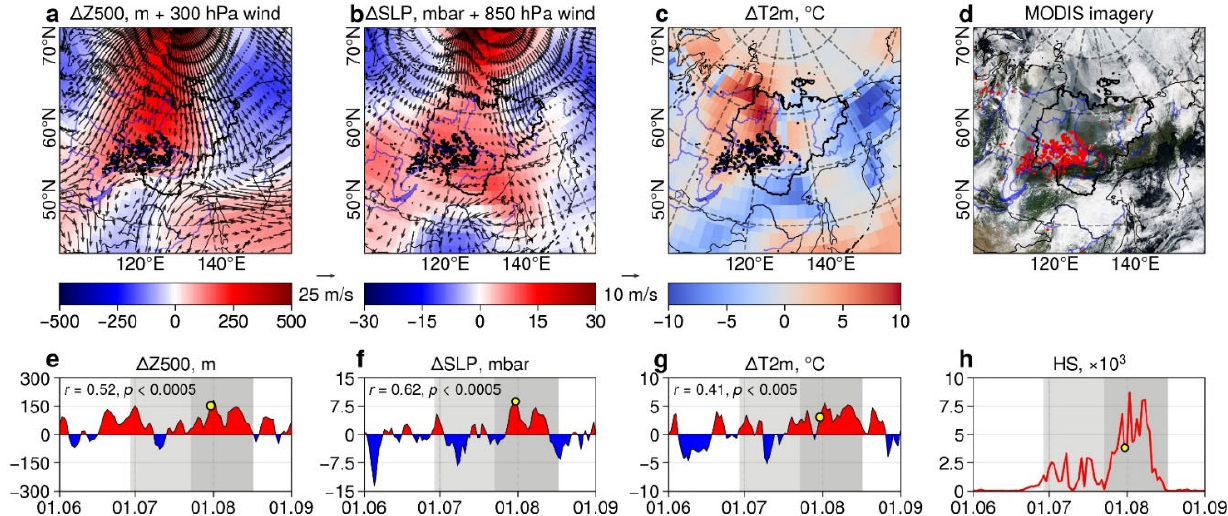
Figure 4. ( a , e ) Geopotential height anomalies at 500 hPa ( ∆ Z500) and vector wind field at 300 hPa; ( b , f ) sea level pressure anomalies ( ∆ SLP) and vector wind field at 10 m; ( c , g ) air temperature anomalies at 2 m ( ∆ T2m); ( d ) MODIS imagery; ( h ) MODIS hotspots. Figures ( a – d ) show weather conditions on 31 July 2021; black ( a – c ) and red ( d ) dots are MODIS HS. Line plots ( e – h ) refer to the study region, the yellow markers indicate 31 July. Grey vertical bars indicate two periods of wildfire activity. Correlation coefficients on figures ( e – g ) indicate correlation between the number of HS and the corresponding parameter during the period from 29 June to 17 August.